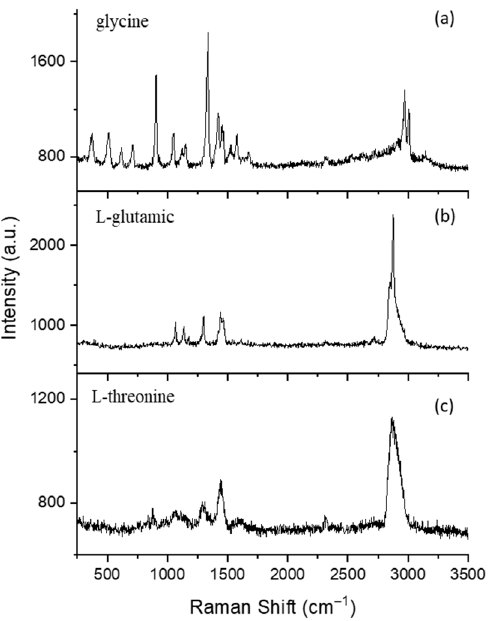
Figure 3. Typical Raman spectra of three types of single amino-acid particles measured by the OT-RS: ( a ) glycine, ( b ) L-glutamic, and ( c ) L-threonine. Glycine